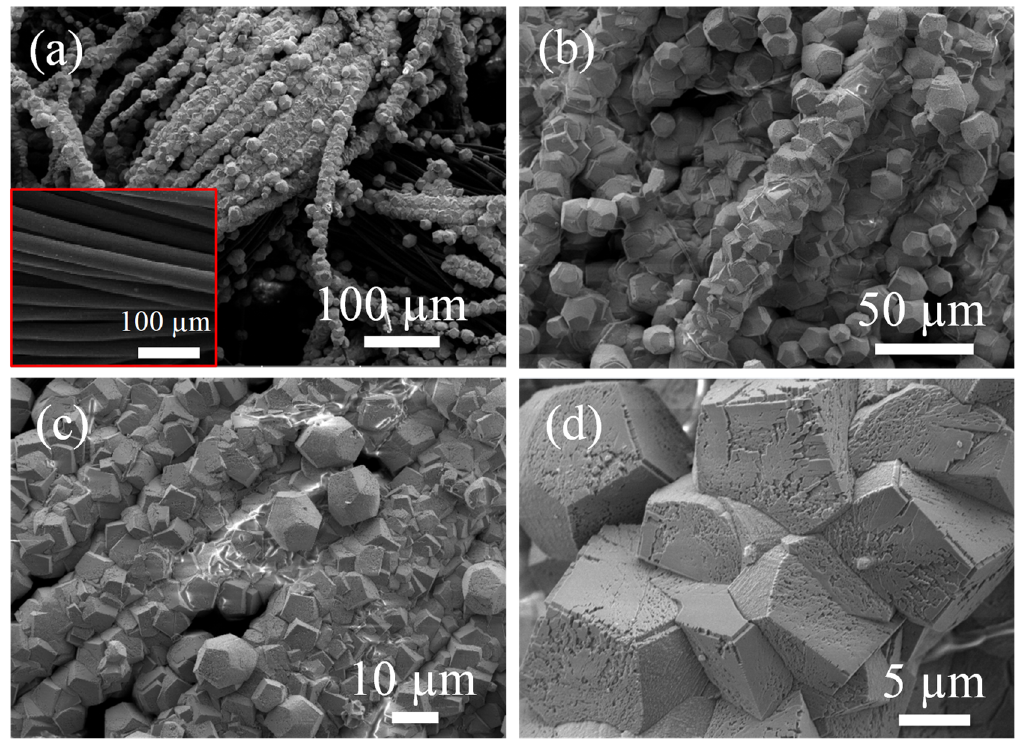
Figure 2. ( a , b ) Low- and ( c , d ) high-resolution SEM images of